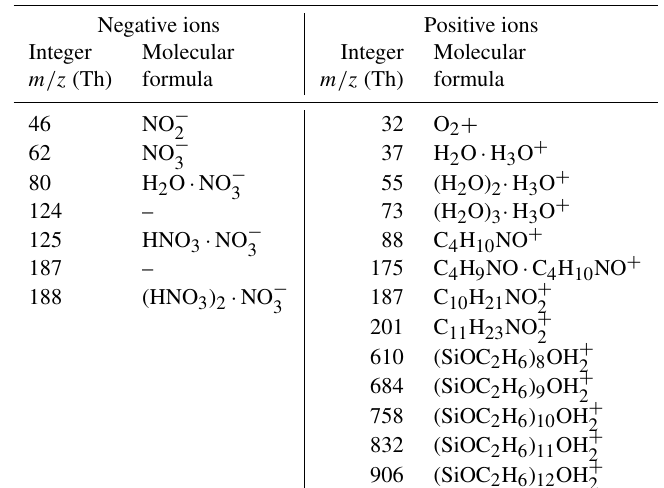
Figure 5. Mobility distributions of the charger ions generated by the plasma torch using N 2 , He and air as the working gas and the 241 Am charger. The upper panel shows the mobility diameter distribution of the positive charger ions; the lower panel presents the mobility diameter distribution of the negative charger ions. Table 3. Overview of major negative and positive compounds in the mass spectra recorded using the ioniAPi-TOF in positive and negative ion